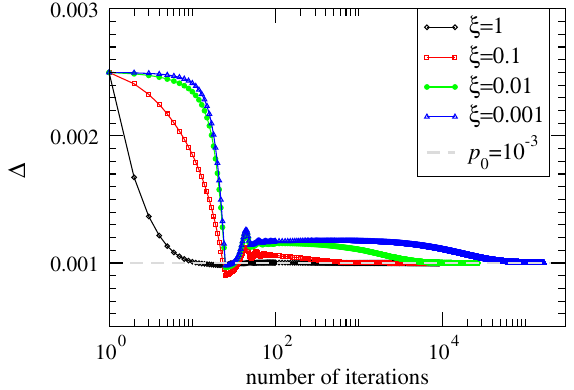
FIG. 9. Instantaneous dimensionless pressure Δ as a function of the number of iterations for one initial condition, taken to be Δ ¼ 0 . 025 . Here we set ¯ α ¼ 10 − 3 , fix the target pressure to Δ 10 − 3 , and observe the form of the convergence of the 0 ¼ instantaneous dimensionless pressure to the target dimensionless pressure, for different values of the Berendsen barostat parameter ξ (see definition in